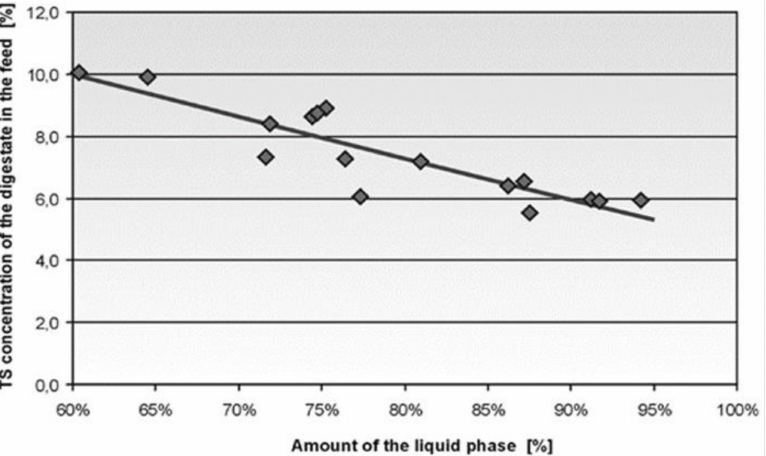
Figure 2. Relationship between the dry matter content in the inflow and the proportion of the liquid phase (pooled data from screw extractor and rotary screen separator experiments reproduced by permission from Bauer et al. 2009